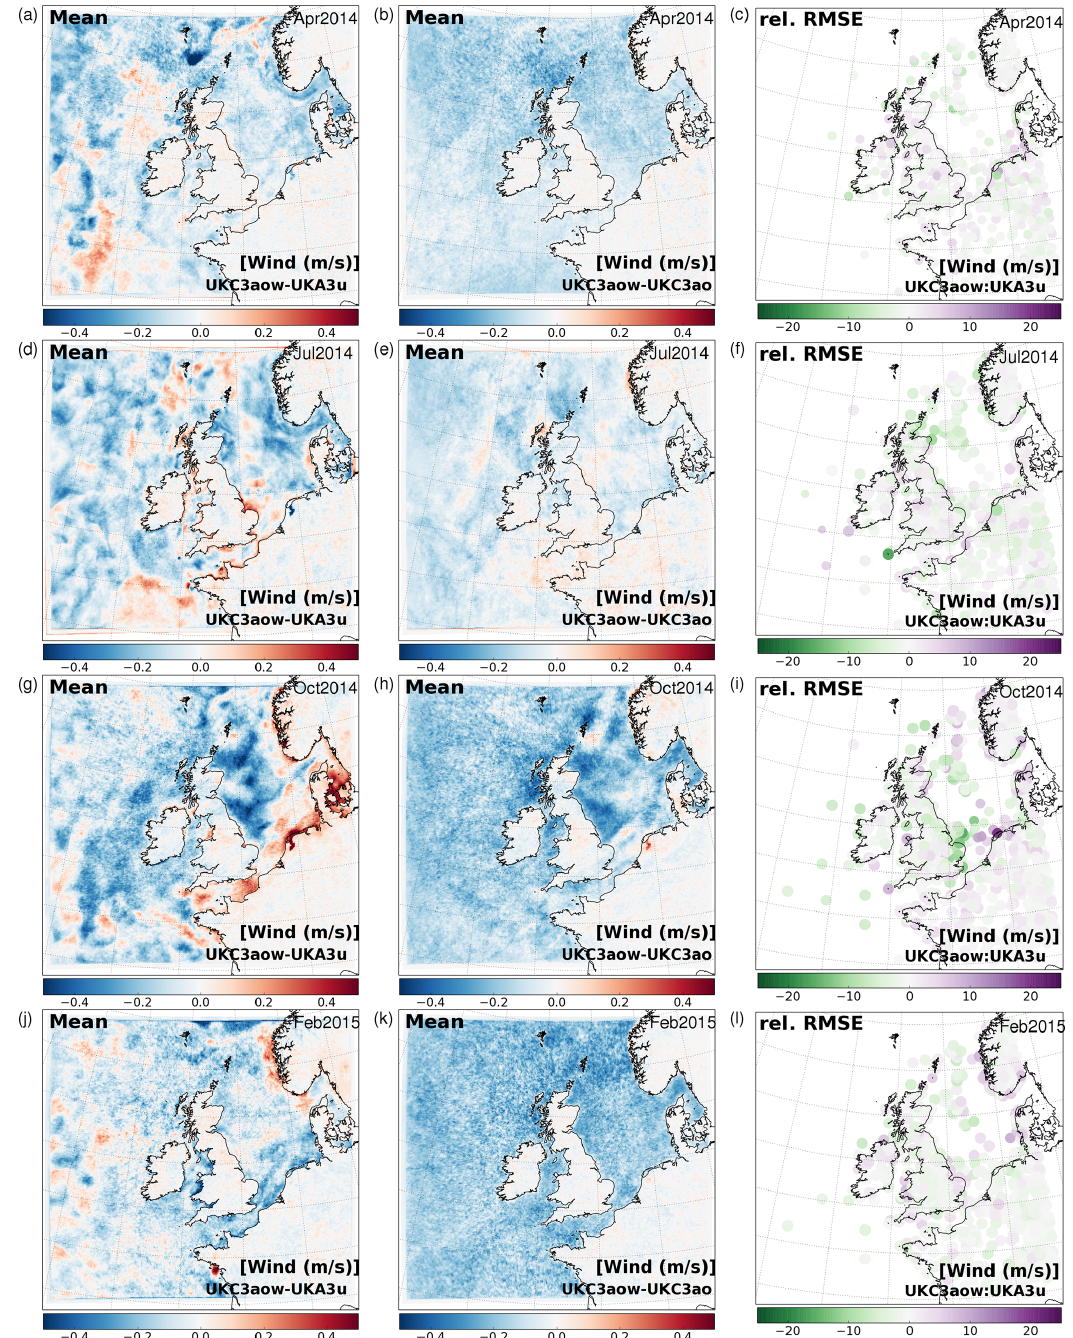
Figure 13. Sensitivity of atmosphere model wind speed at 10m above surface to coupling. (a, d, g, j) Monthly mean difference between fully coupled and daily-updated OSTIA (UKC3aow–UKA3u) during April, July, October 2014 and February 2015 runs, respectively. (b, e, h, k) Monthly mean difference between fully coupled and partially coupled (UKC3aow–UKC3ao) runs during each experiment. (c, f, i, l) Percentage difference in wind speed RMSE statistic for UKC3aow relative to